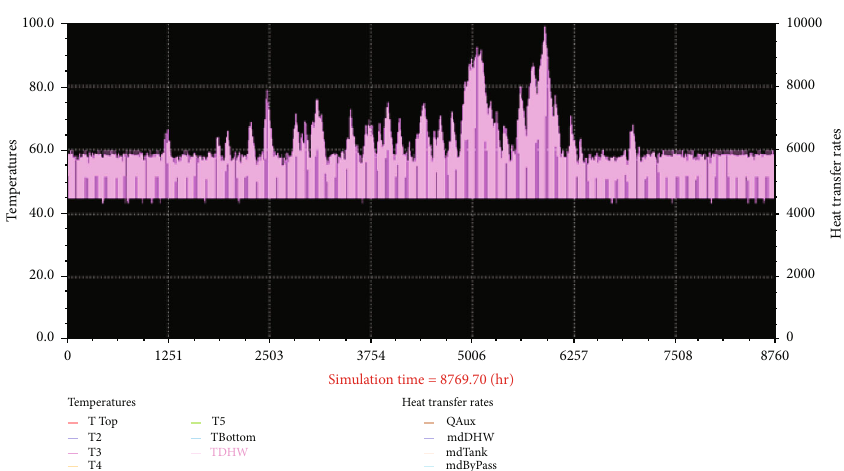
Figure 10: The hot power temperature produced by the solar water heater